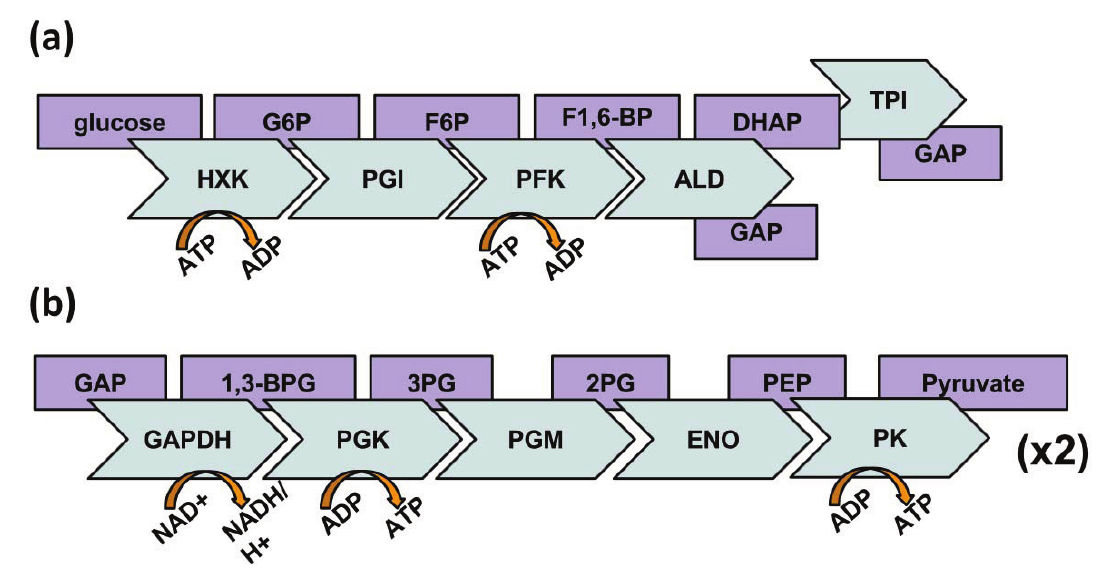
dehydrogenase (GAPDH); Phosphoglycerate Kinase (PGK); Enolase (ENO); Pyruvate Kinase